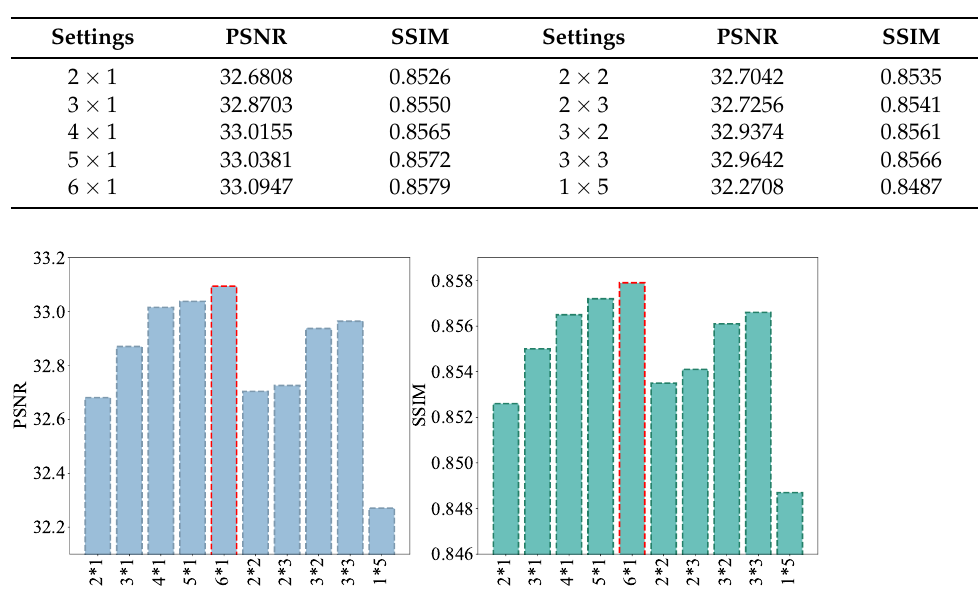
Figure 12. The average PSNR and SSIM for the verification of the best model settings. The average values are calculated from the three datasets and seven ratios. The best choice of 6 × 1 is marked with the red dotted